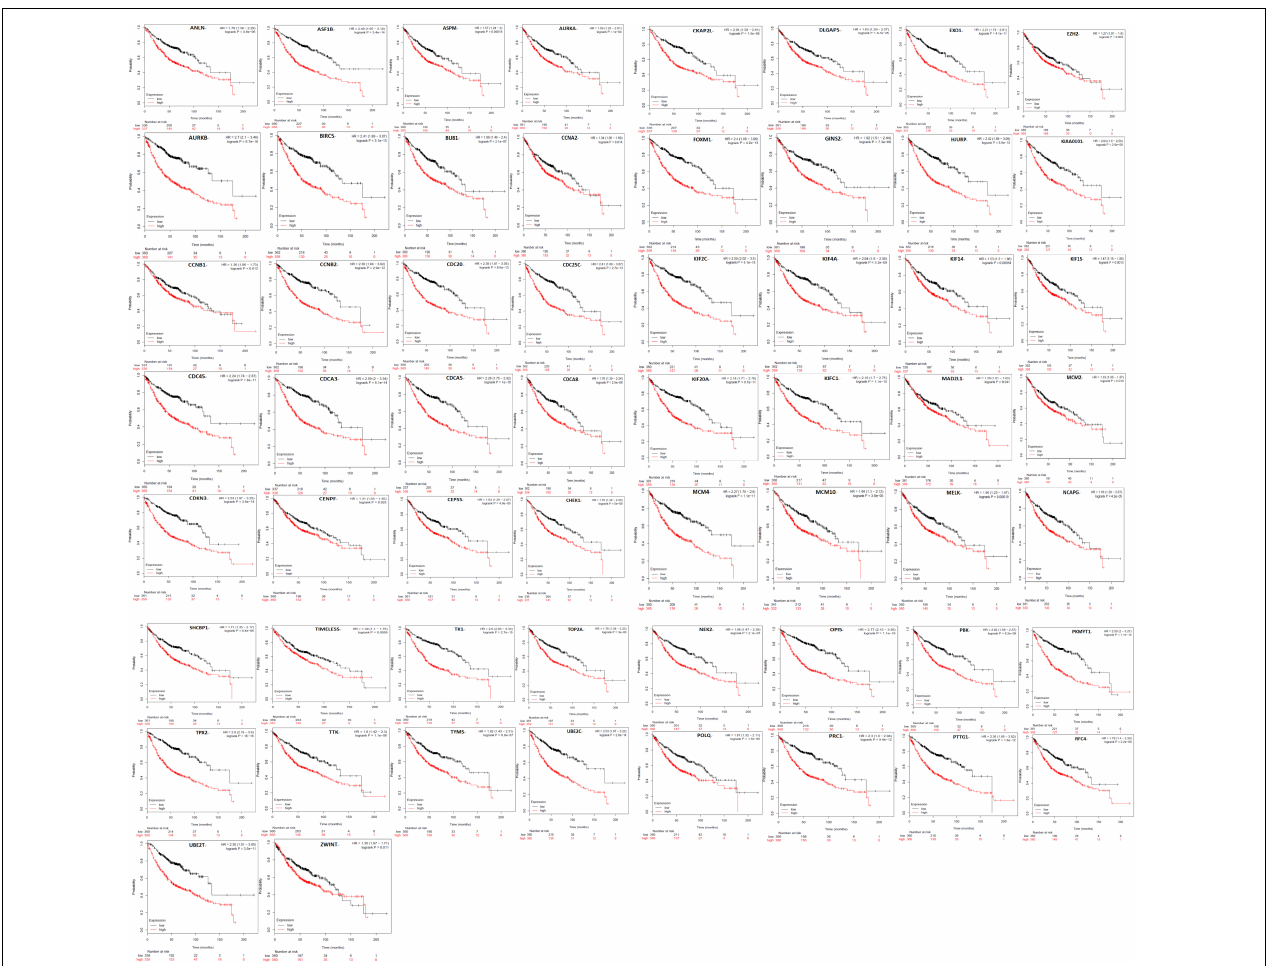
FIGURE 3 | A total of 58 of 72 genes had a significantly poor survival rate in LUAD via Kaplan meier plotter online tools ( P < 0.05).